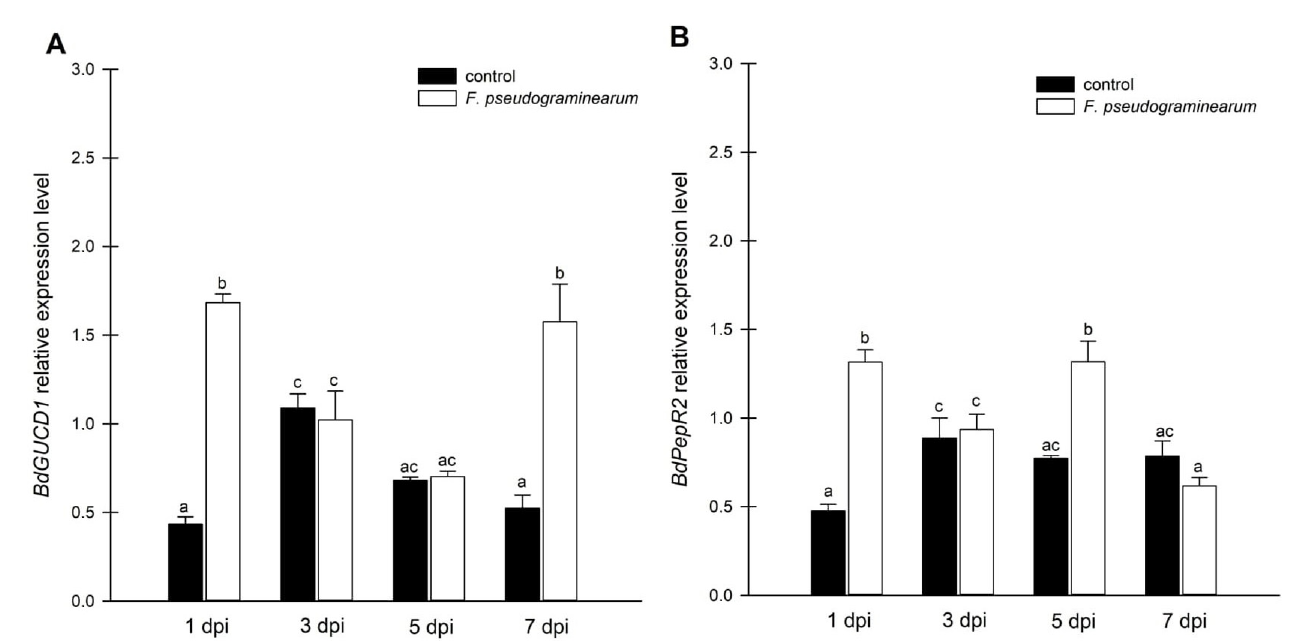
Figure 3. Expression analysis of guanylyl cyclase genes in F. pseudograminearum -infected B. distachyon plants. ( A ) mRNA levels of BdGUCD1 in B. distachyon in response to F. pseudograminearum infection; ( B ) mRNA levels of BdPepR2 in B. distachyon in response to F. pseudograminearum infection. Control plants were not infected or treated with the inhibitor. Different letters above the bars indicate significant differences at p < 0.05 (ANOVA followed by Tukey’s test).